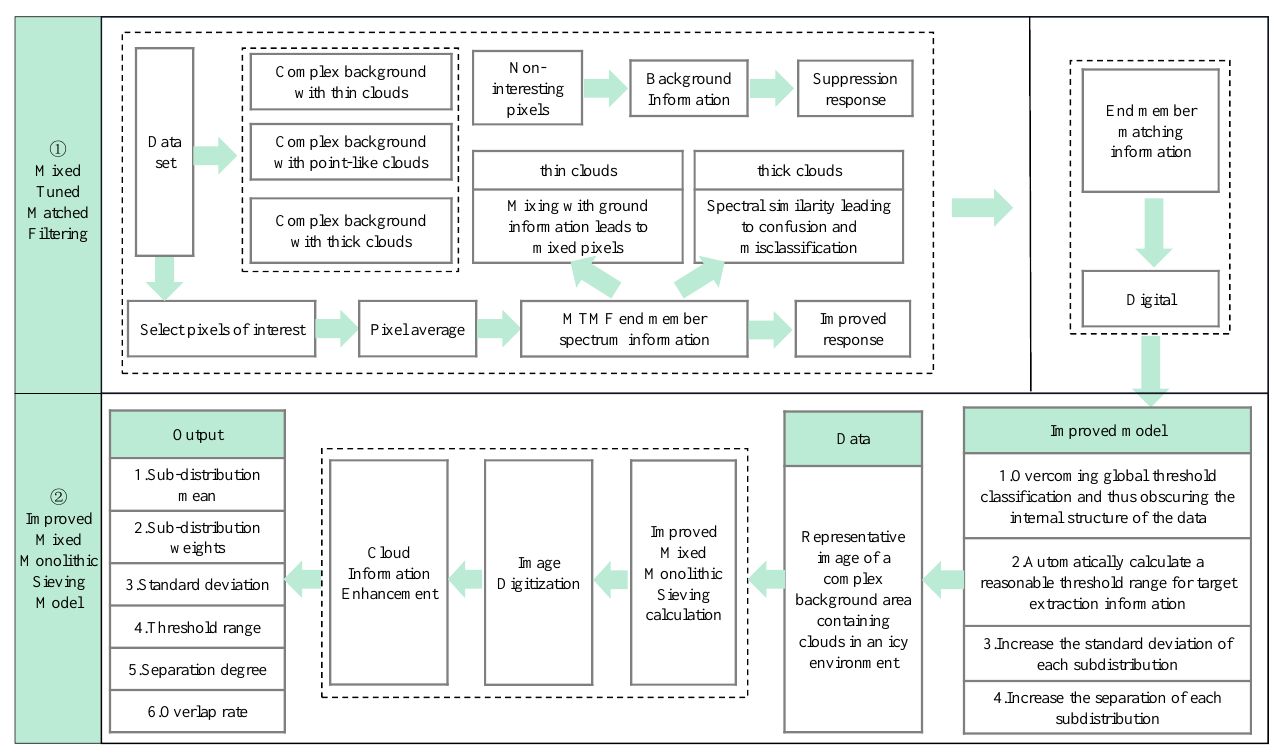
Figure 2. Proposed method framework.